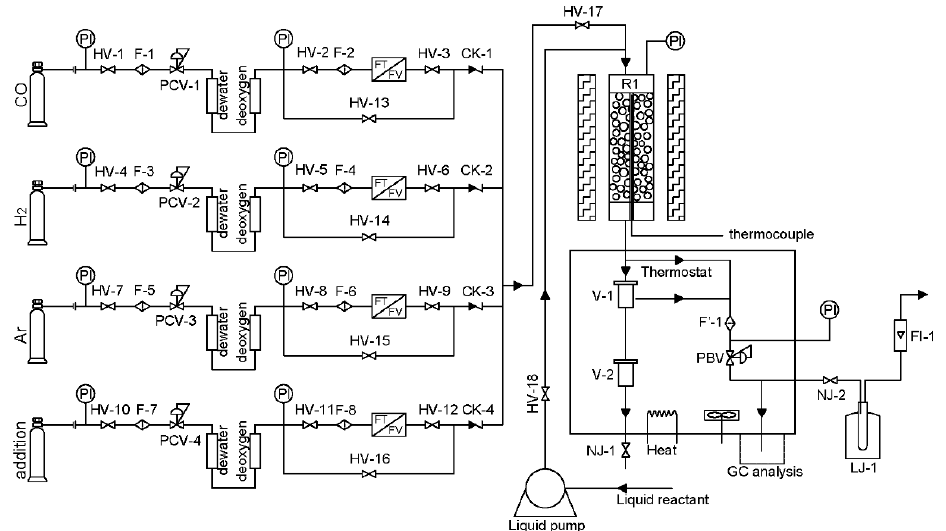
Figure 1. Schematic apparatus of the fixed-bed reactor for FTS mechanism experiments (HV, globe valves; F, filter; CK, non-return valves; PCV, pressure reducing valves; F’, thermal resistant filter; NJ, thermal resistant globe valves; R1, fixed-bed reactor; PBV, back-pressure regulator; LJ, cold trap; FI, flow meter; V, gas–liquid separator).